Question: Compose a caption that would accompany this figure in a paper.
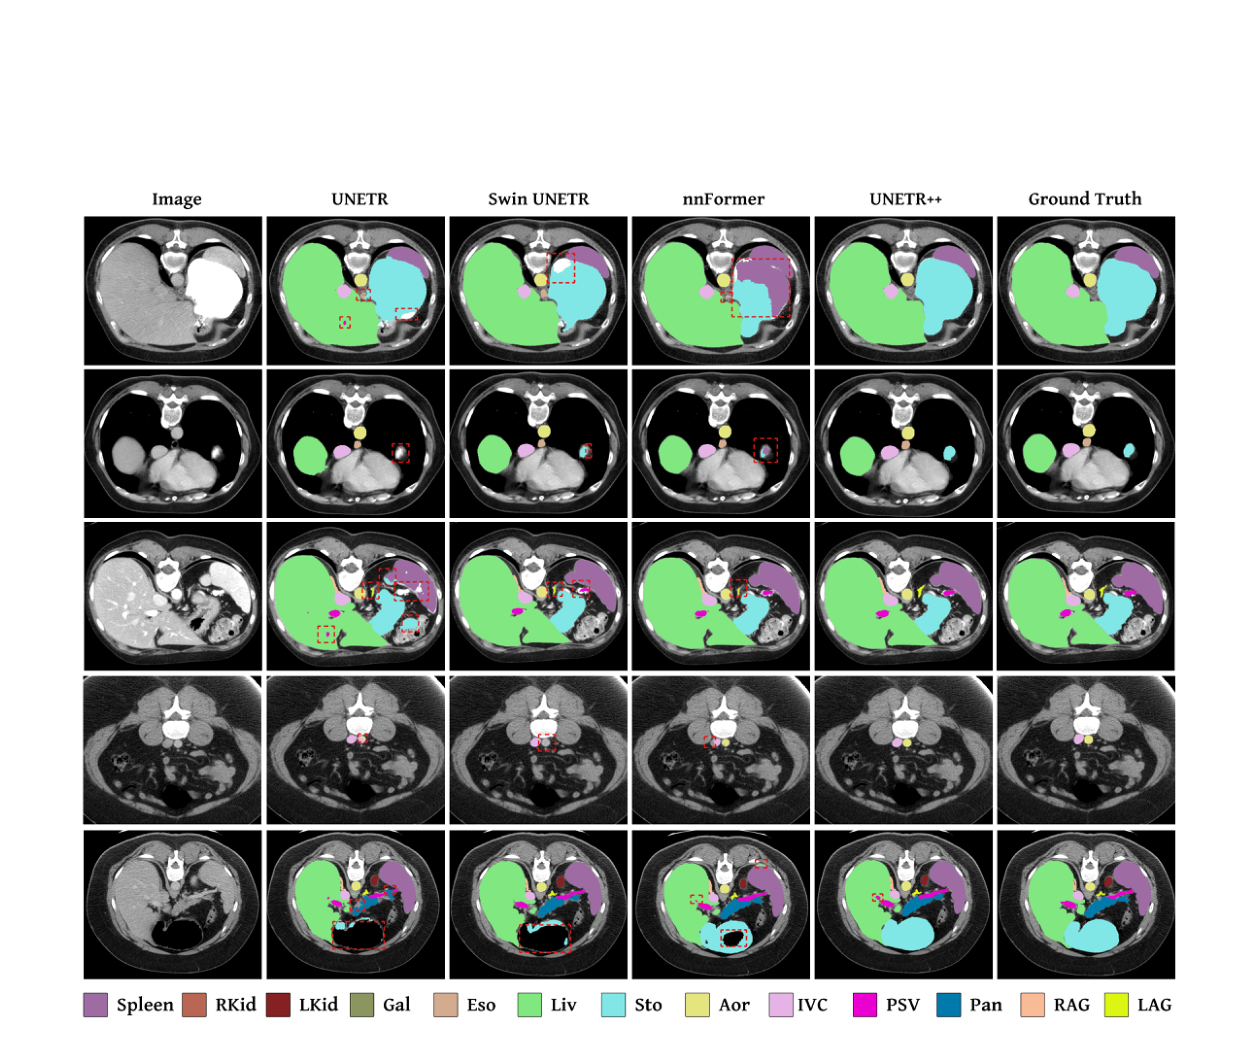
Answer: Additional qualitative comparison on Synapse dataset. We compare our UNETR++ with existing methods: UNETR, Swin UNETR, and nnFormer. It is noticeable that the existing methods struggle to correctly segment different organs (marked in red dashed box). Our UNETR++ achieves promising segmentation performance by accurately segmenting the organs. Best viewed zoomed in.